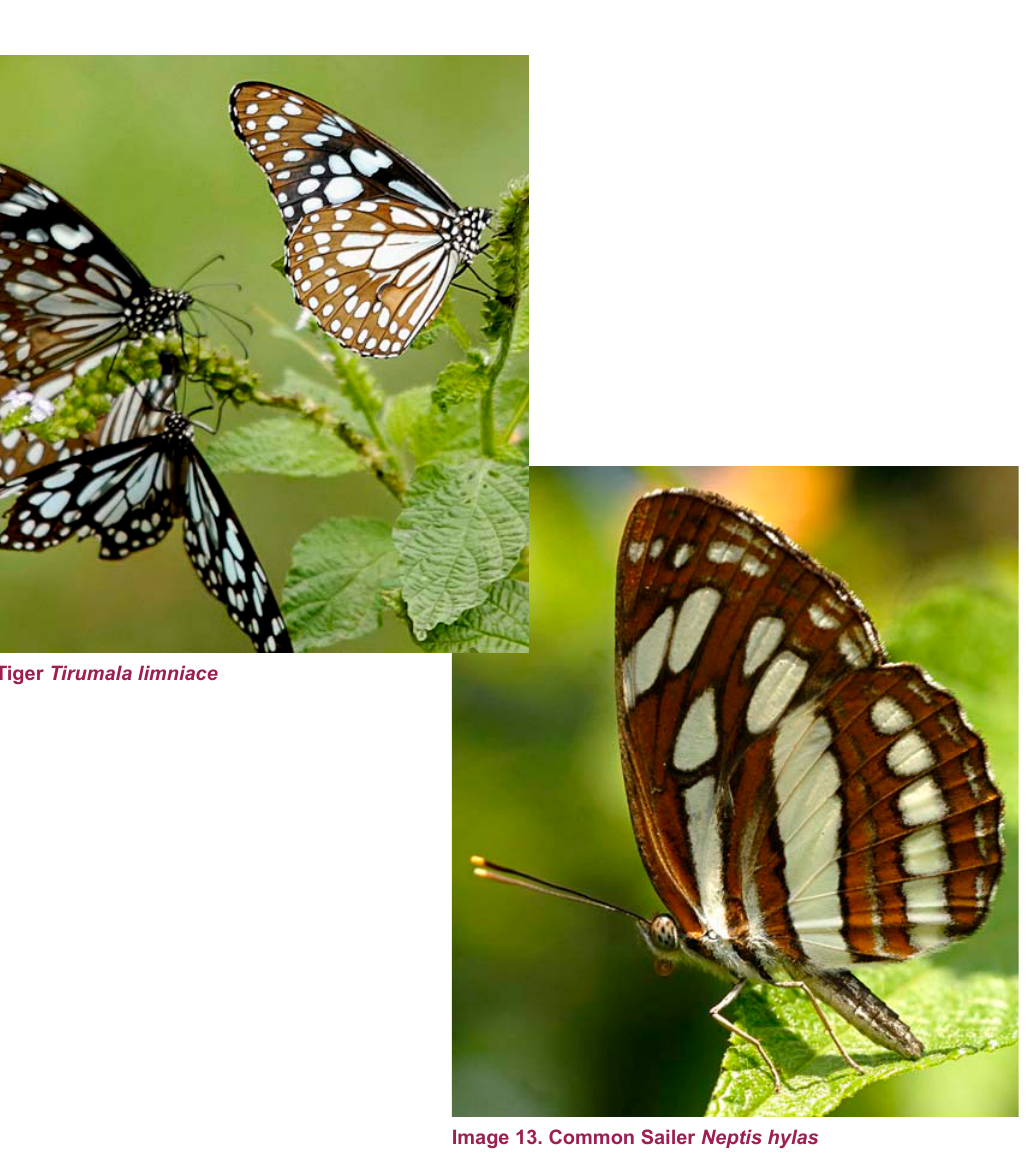
Image 13. Common Sailer Neptis hylas